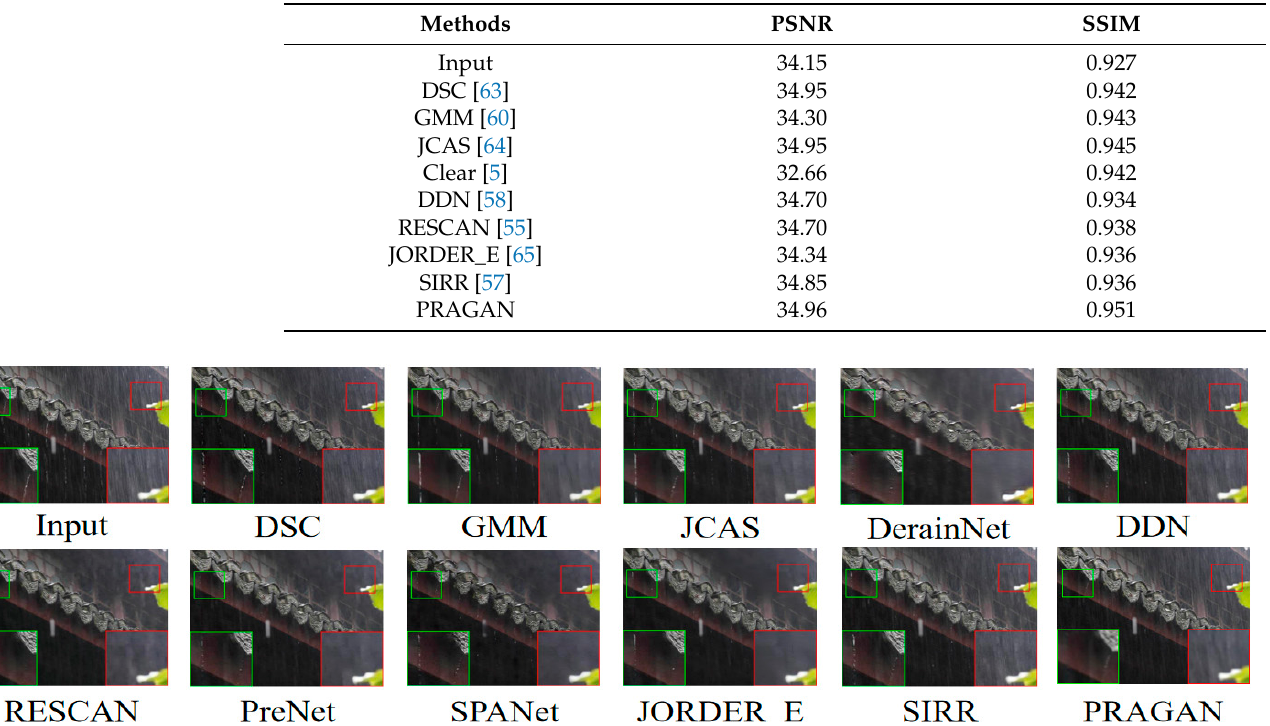
Table 7. Comparisons on real-world dataset SPA-Data [61].